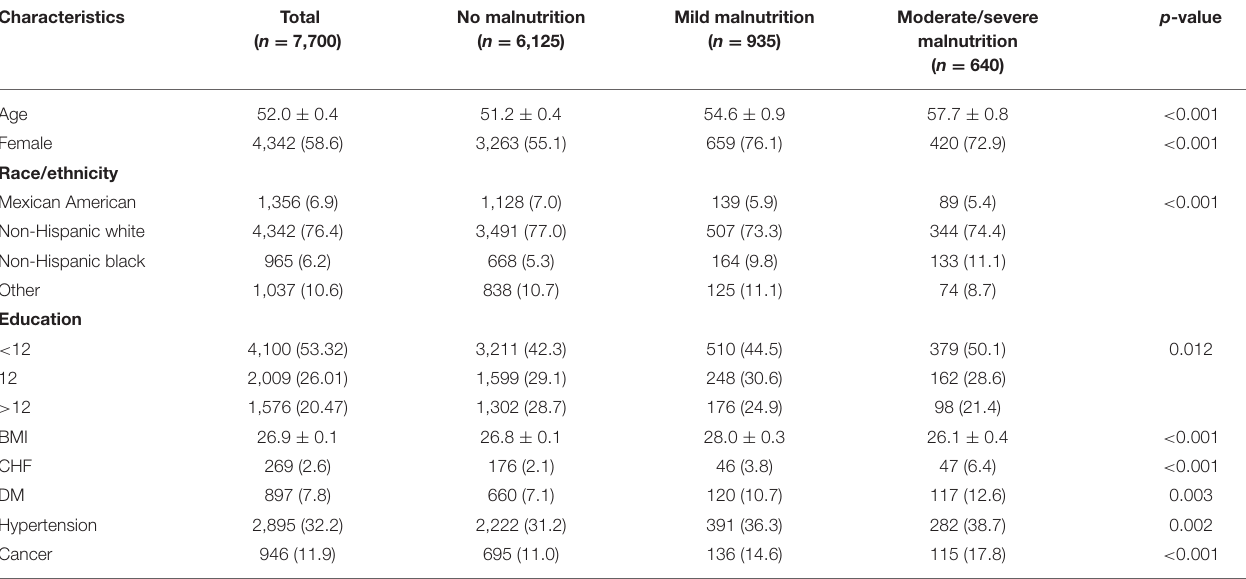
TABLE 1 | Baseline characteristics of the study population (weighted).